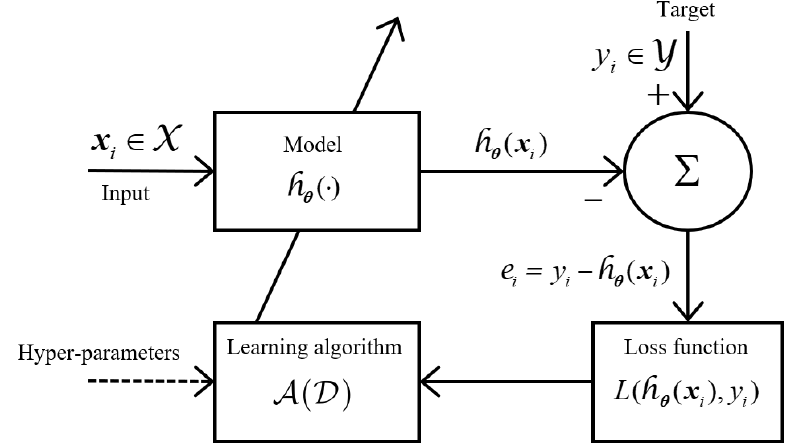
Figure 4. Schematic diagram for training a ML